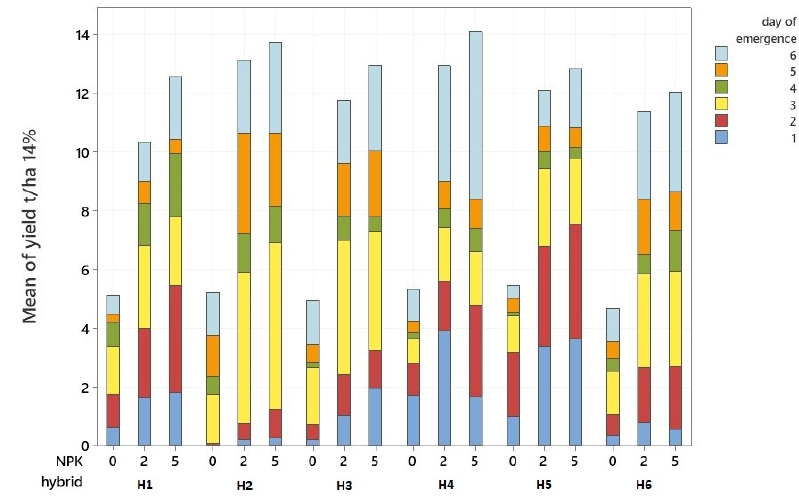
Figure 3. Interaction between hybrids, fertilizer, and day of emergence on yield.